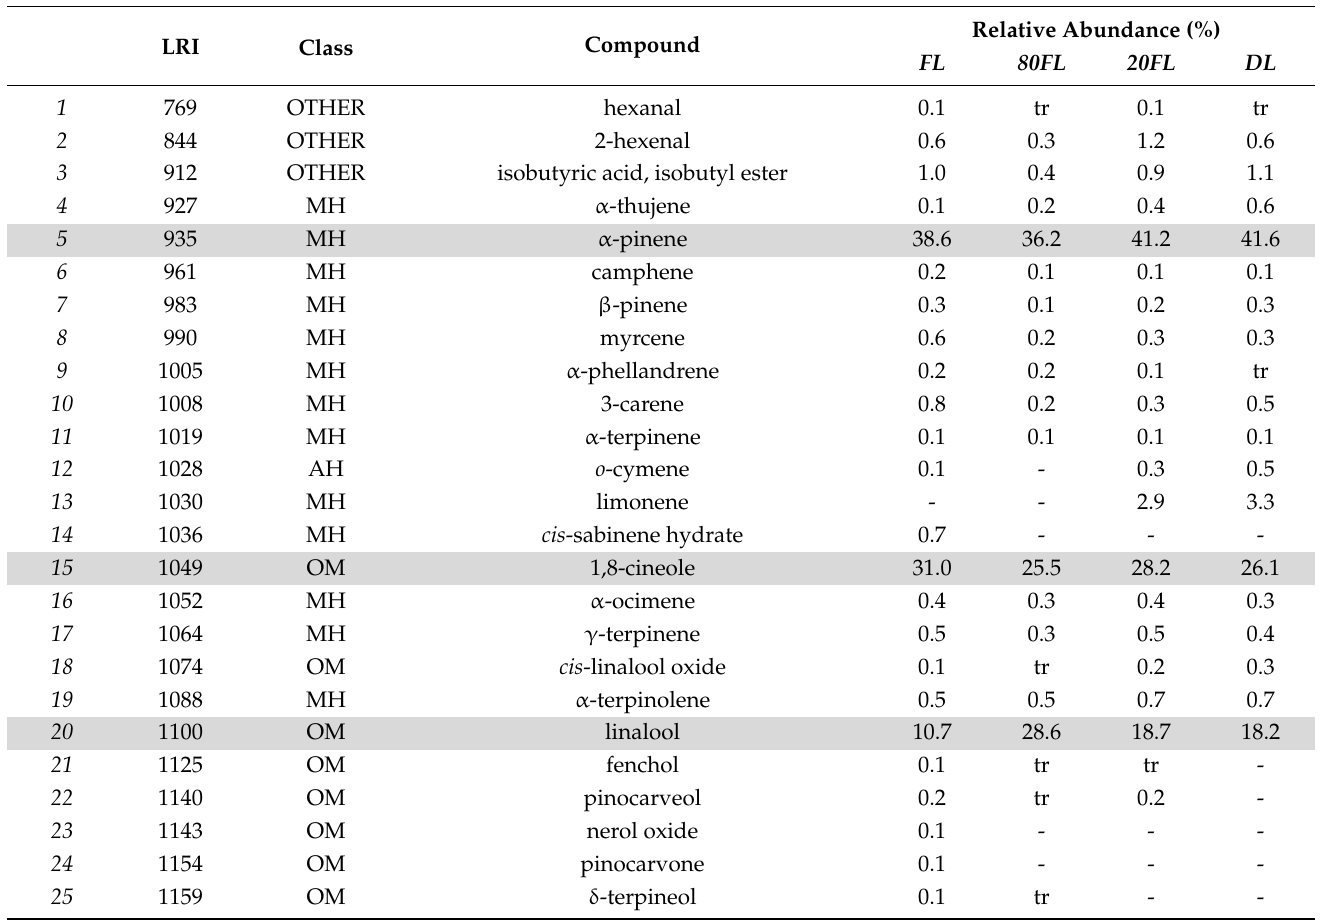
Table 1. GC-MS profiles of the essential oils obtained from the leaves of Myrtus communis subsp. communis collected in July 2018 following different preservation procedures: hydro-distillation as